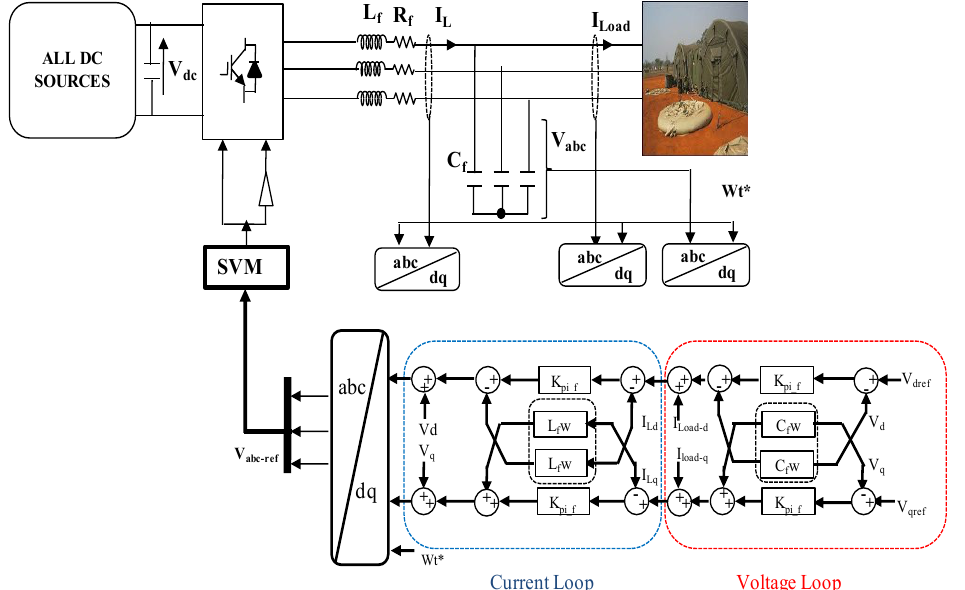
Figure 11. dq-frame control method for AC